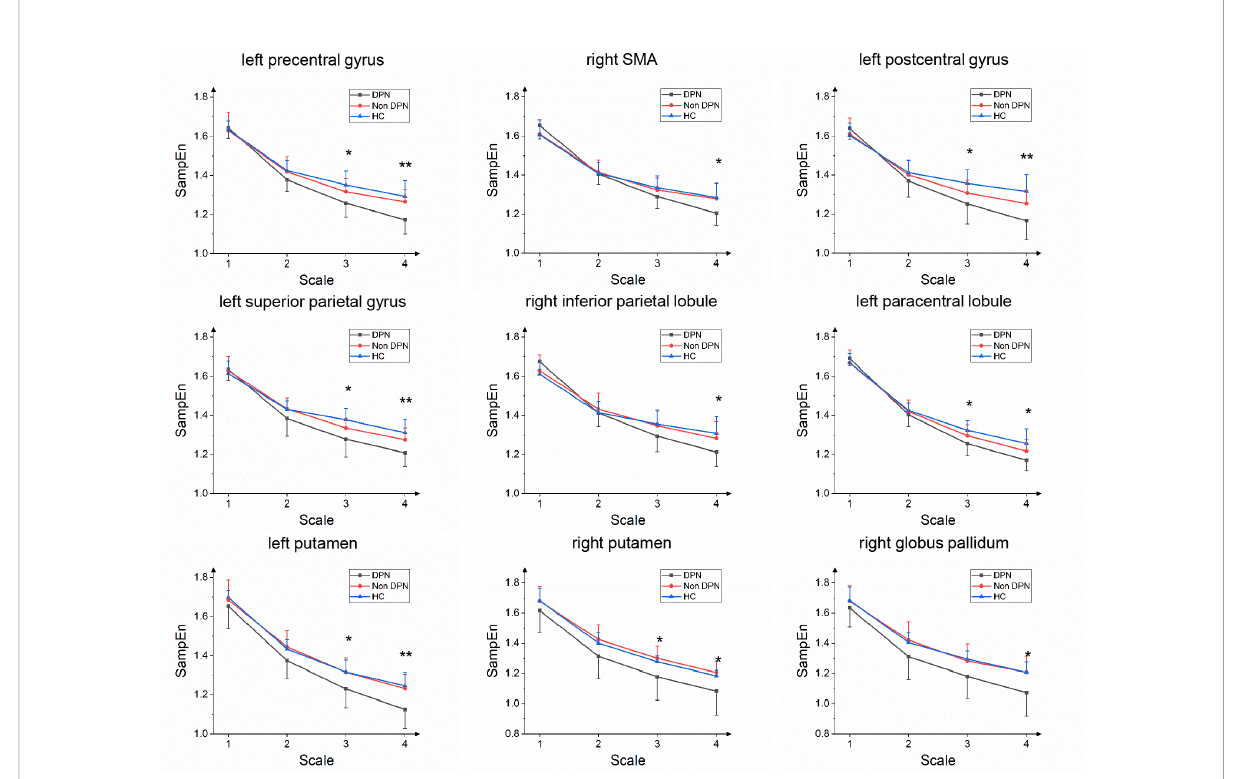
FIGURE 2 Group average SampEn over multiple time scales of left precentral gyrus, right supplementary motor area(SMA), left postcentral gyrus, left superior parietal gyrus, right inferior parietal lobule, left paracentral lobule, left and right putamen, right globus pallidum in the DPN group compared with the non-DPN group. (*, p<0.05; **,